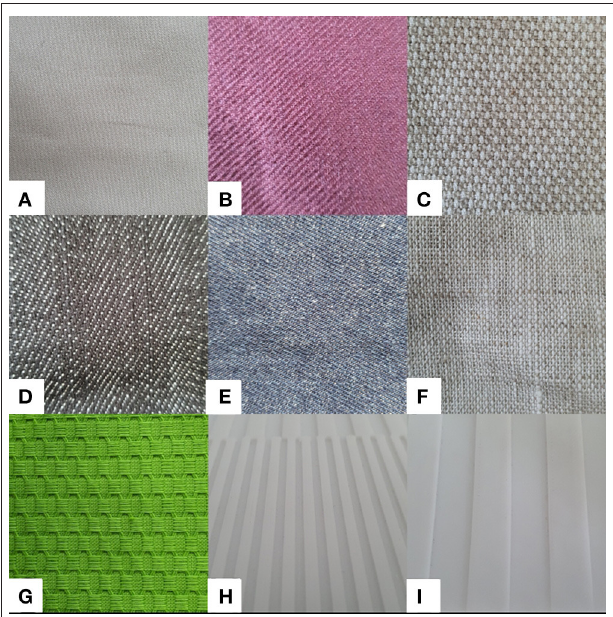
FIGURE 4 | Fabric samples (A) BeigeCotton , (B) BrownCotton , (C) Canvas , (D) Denim , (E) DenimFlex , (F) Linen , (G) WovenFabric , (H) Board2mm , and (I) Board10mm . Labels of the fabrics are only for identification in the experiments and are not related to the exact material or any